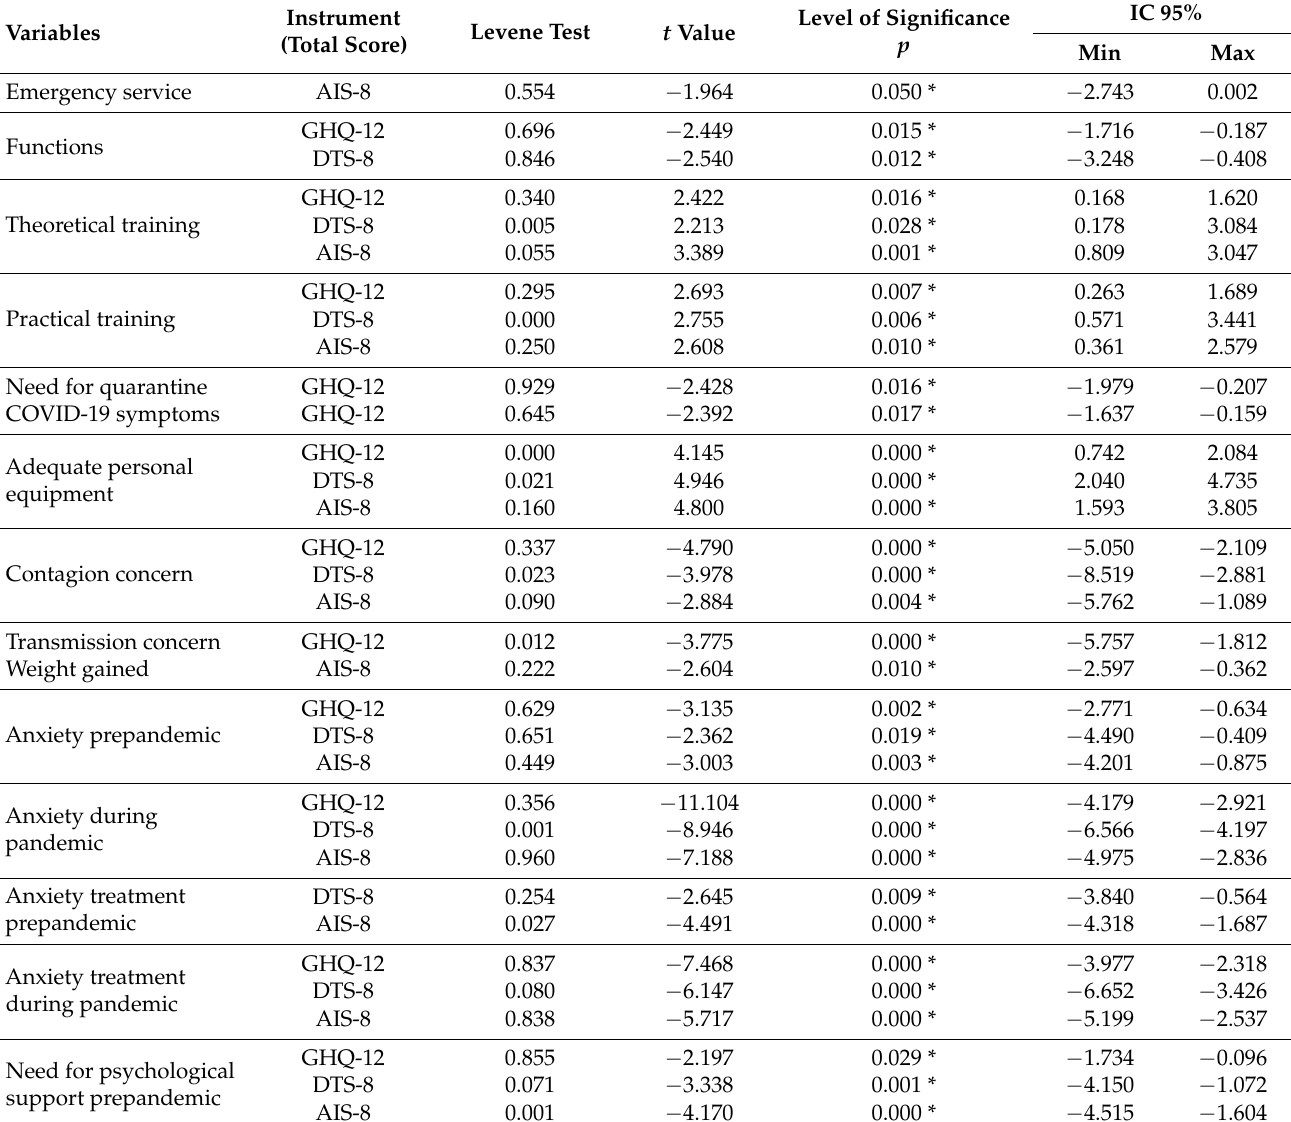
Table 3. Inferential analysis: Student t test means